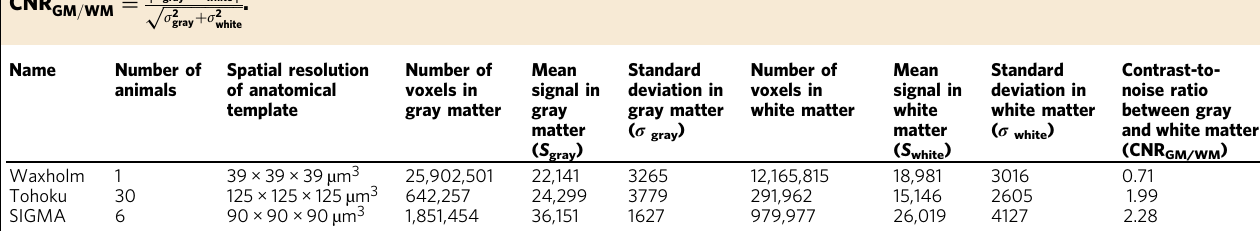
Table 2 Comparison of the Contrast-to-Noise Ratio (CNR) between the Gray Matter (GM) and the White Matter (WM) for the Waxholm, Tohoku and SIGMA anatomical templates of rat brain computed as proposed by Tapiovaara et al. 25 : j j ffiffiffiffiffiffiffiffiffiffiffiffiffiffiffiffiffi p . ¼ S gray (cid:2) S white CNR GM = WM σ 2 þ σ 2 gray white